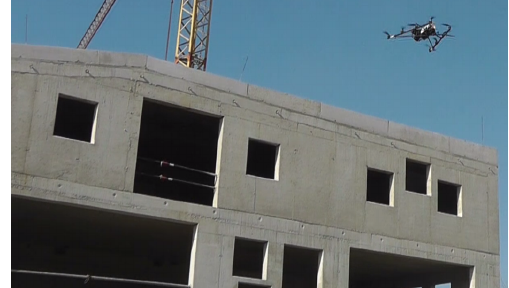
Figure 1. Octocopter with Nex-7 camera mounted in front of the construction site